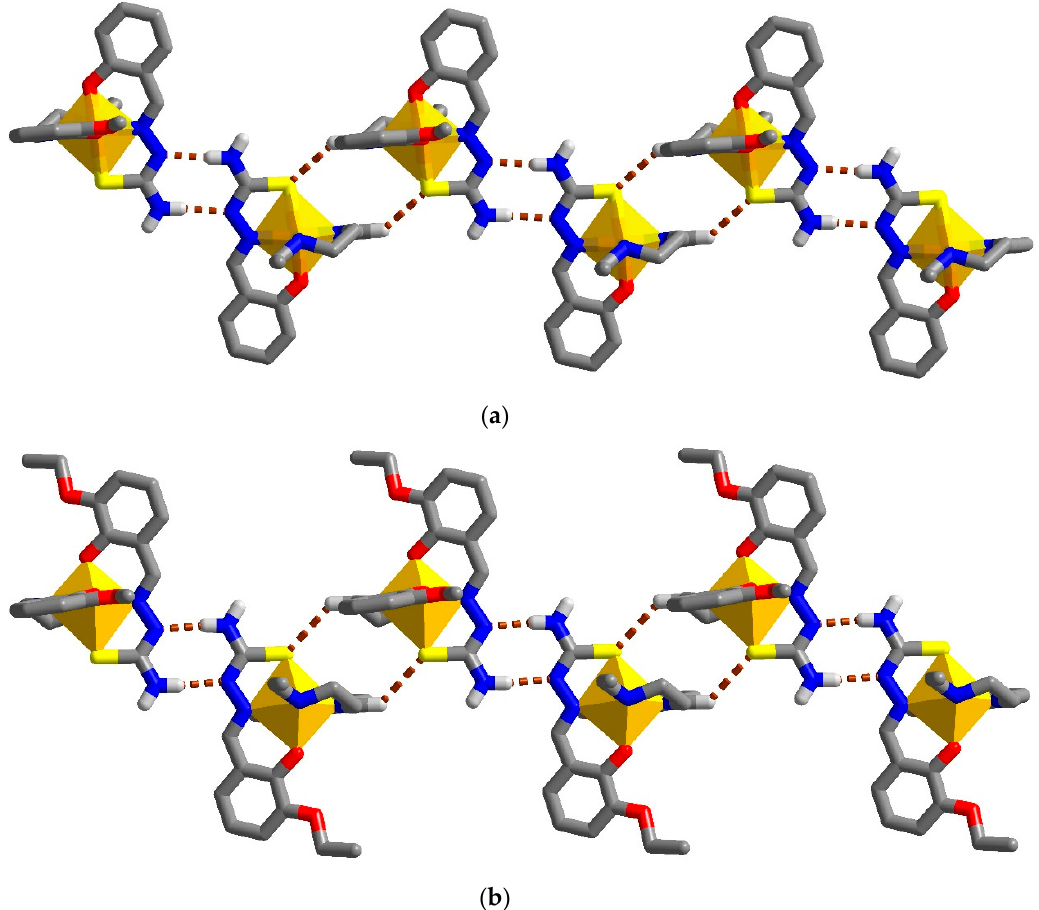
Figure 3. C–H···S and N–H···N interactions that show similarly connecting Fe(III) molecules in ( a ) 1 and ( b ) 2 . Colour coding: O, red; N, blue; S, yellow; C, grey; H, white; yellow octahedra show coordination environment around Fe.